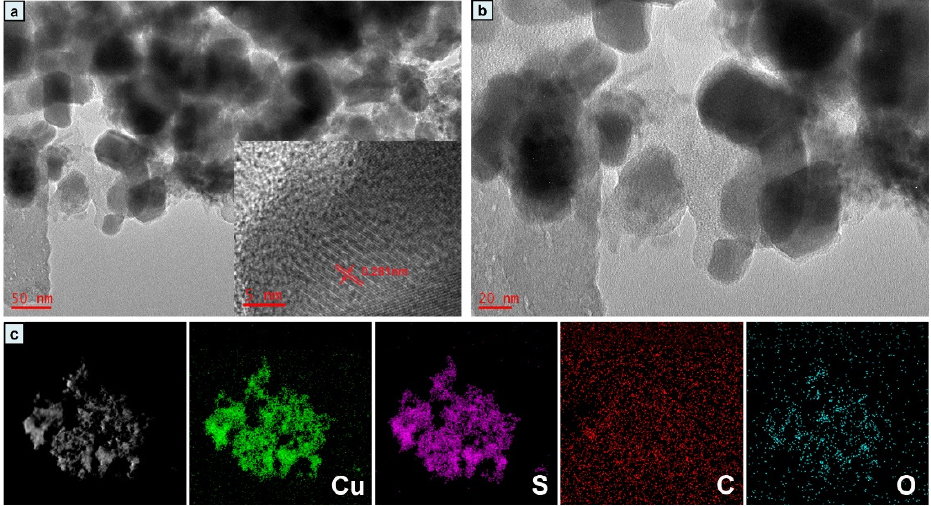
Figure 4. Low and high magnification SEM images of ( a , b ) CuS/C ‐ 80, ( c , d ) CuS/C ‐ 120, and ( e , f ) CuS/C ‐ 160.